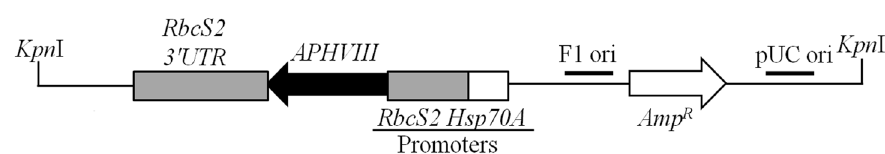
Figure 1. Linearized pBC1 plasmid used for random insertional mutagenesis. The cleavage site of the Kpn 1 restriction enzyme, used for linearization of the vector is shown. APHVIII is under the control of combo promoters consisting of the promoter of the gene encoding the small subunit of Rubisco (RbcS2) and the promoter of the gene encoding the heat shock protein 70A (Hsp70A). pBC1 is a phagemid and its F1 origin (F1 ori) and pUC origin (pUC ori) are shown. The size of the plasmid is 4763 bp.